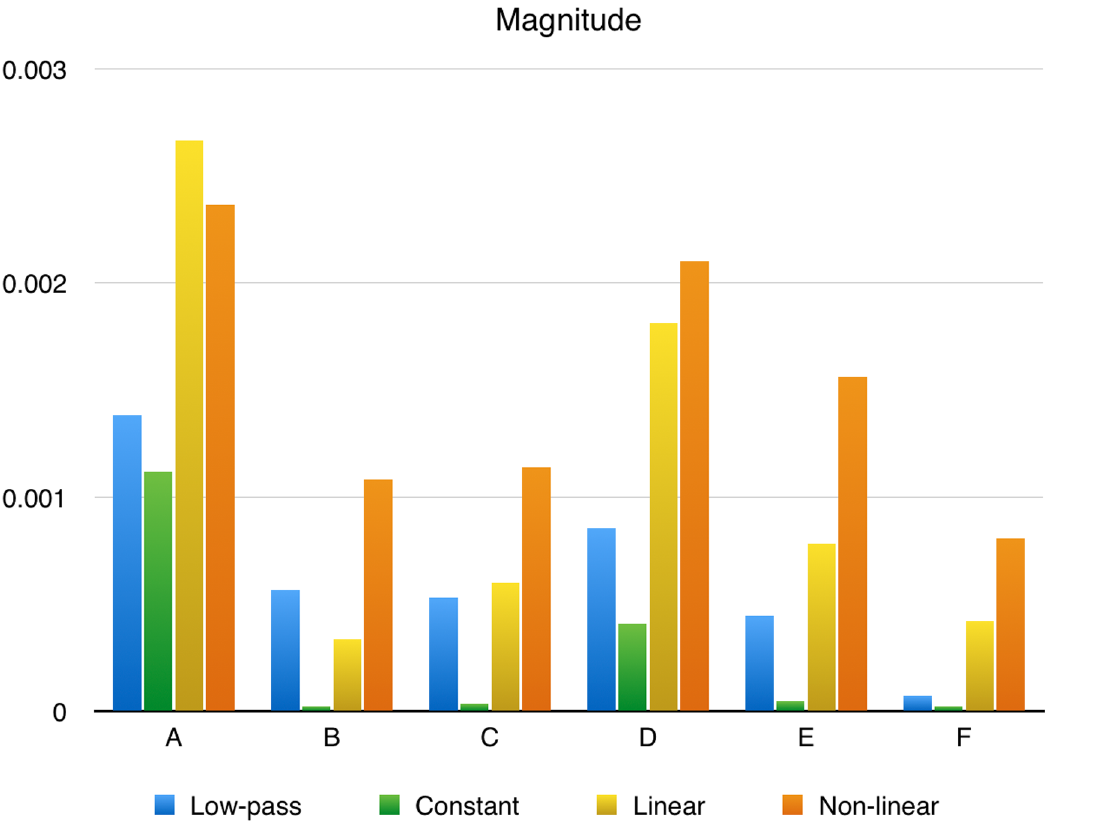
Fig 5. Average response magnitudes. The response magnitude for the different data sets and methods.